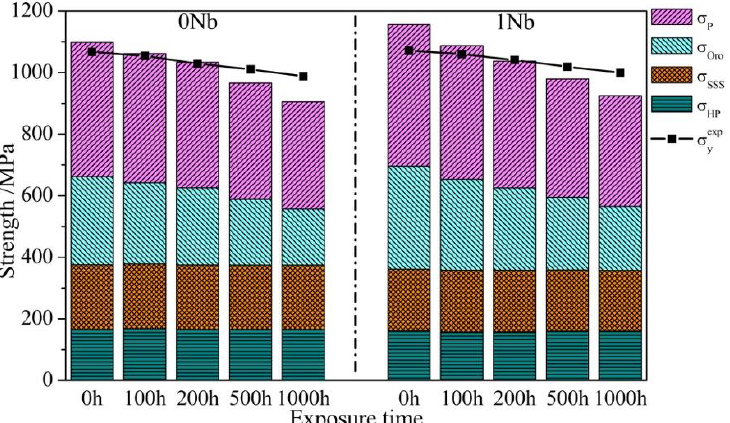
Figure 11. Extent of each strengthening mechanisms to the yield strength at ambient temperature in 0Nb and 1Nb alloys where all samples were exposed at 800 °C.